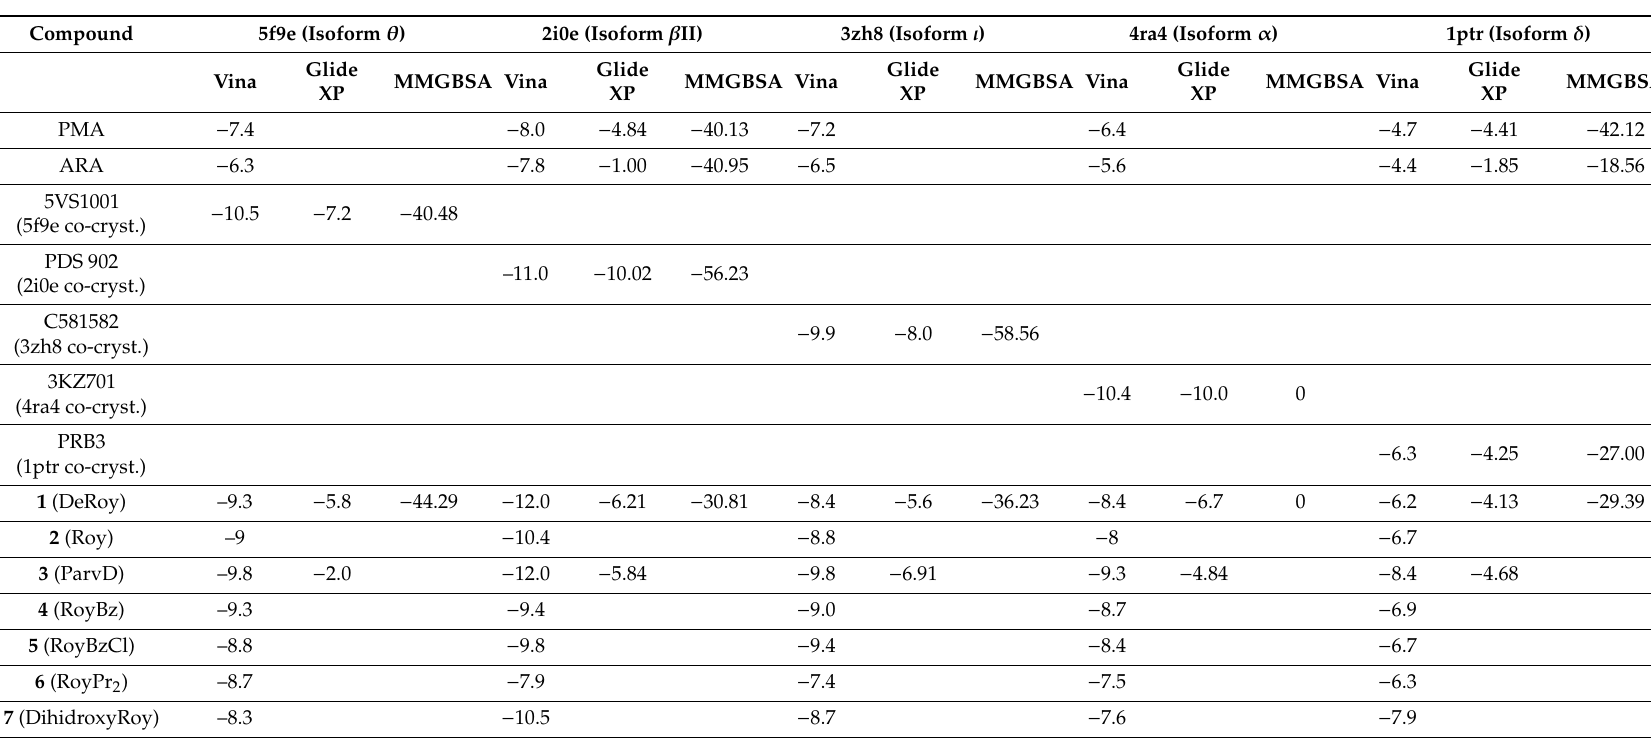
Table 2. Calculated docking scores for compounds against PKC isoforms. All values in kcal /